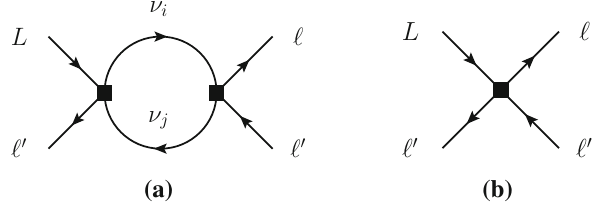
Fig. 2 Example of two diagrams mediating L → (cid:3)(cid:3) (cid:3) (cid:3) (cid:3) in a low energy effective field theory